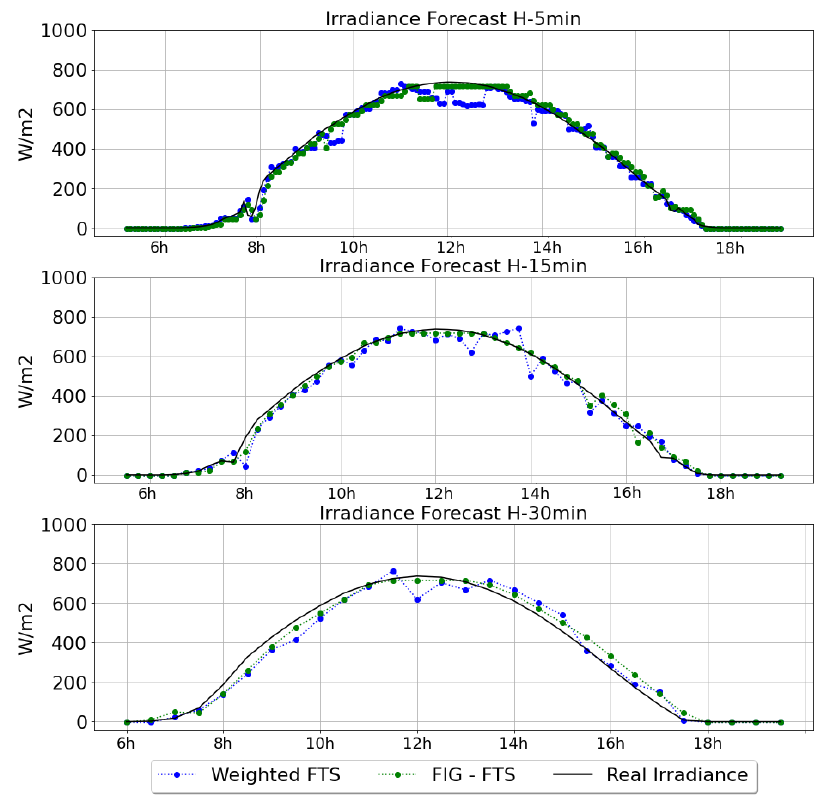
Figure 5. Example of GHI prediction using FTS methods with three time horizons.